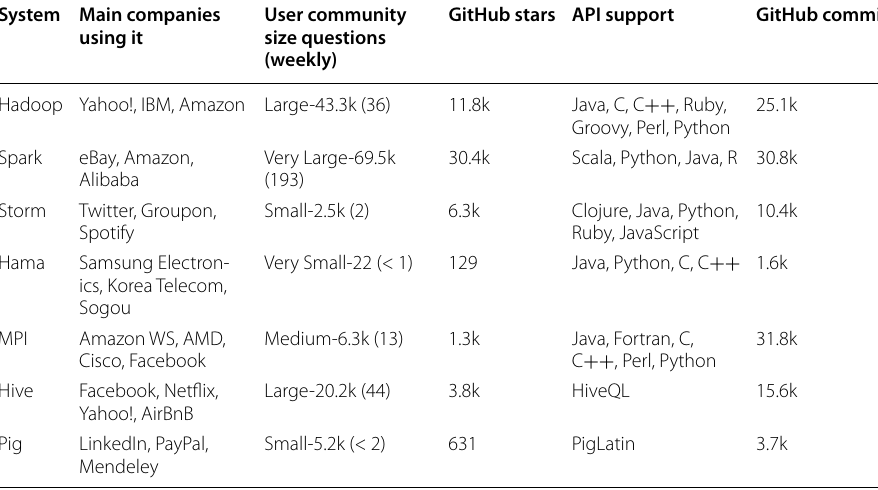
Table 2 Diffusion and popularity of the systems System Main companies using it